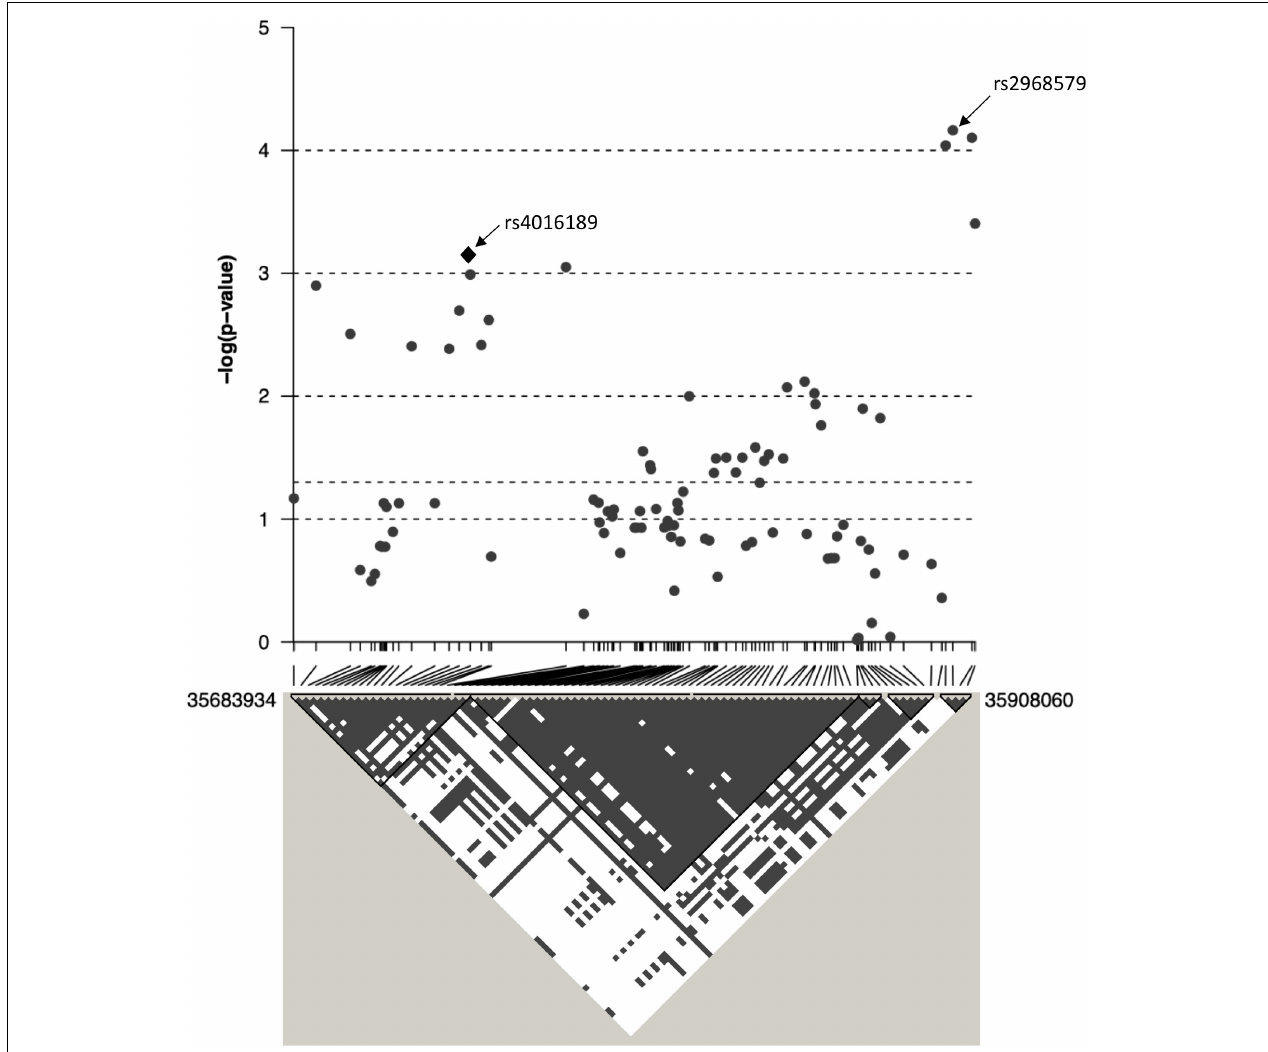
FIGURE 3 | The association between ACR and 97 SNPs in the region surrounding rs4016189 is displayed as –log10 p -values. CRIM1 gene lies 448 kb upstream of the region displayed on this graph. Positions are based on ensembl GRCh38.p12. Below the graph, the linkage disequilibrium between each of the 97 SNPs is displayed as gray/white squares, using the four gamete rule . SNPs that do not show all four possible haplotypes/gametes (i.e., in LD) are colored gray (as opposed to